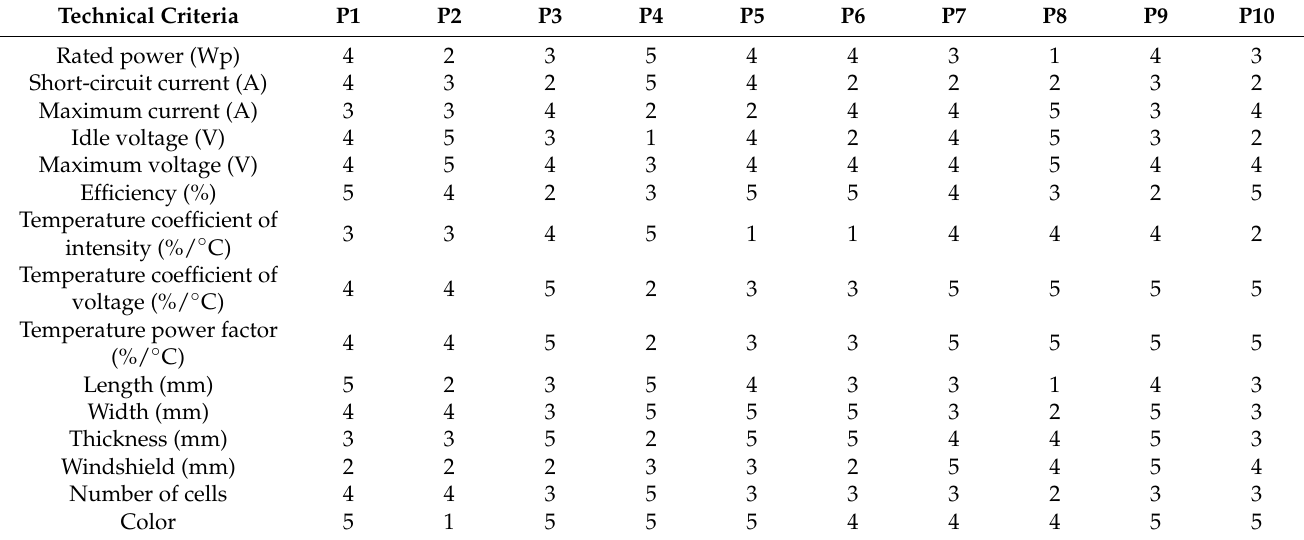
Table 6. Assessment of quality of photovoltaic panels technical criteria in Likert scale.